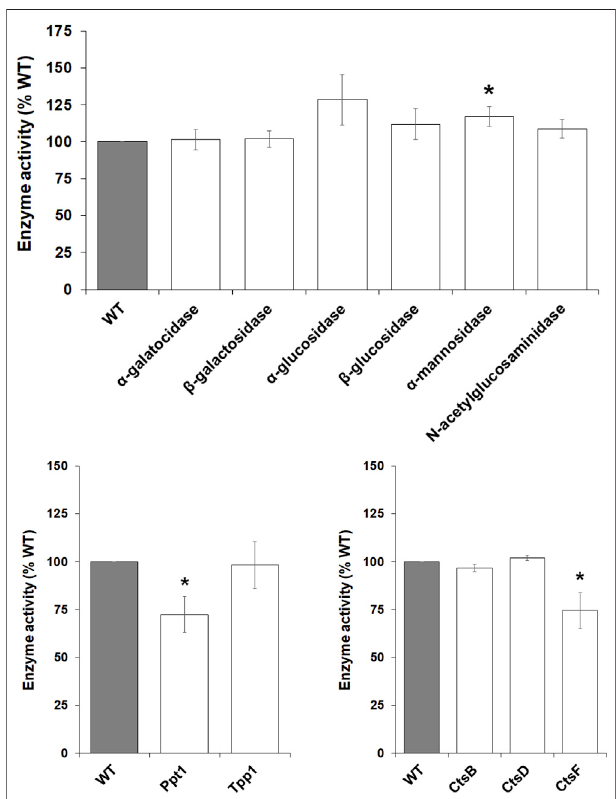
FIGURE 9 | Effect of mfsd8 -de fi ciency on enzyme activity during starvation. WT and mfsd8 − cells grown axenically in HL5 were starved in KK2 buffer for 4 h, after which time cells were lysed. The activities of α - galactosidase, β -galactosidase, α -glucosidase, β -glucosidase, α - mannosidase, N-acetylglucosaminidase, palmitoyl-protein thioesterase 1 (Ppt1), tripeptidyl peptidase 1 (Tpp1), cathepsin B (CtsB), cathepsin D (CtsD), and cathepsin F (CtsF) were assessed as described in the Materials and Methods. Data presented as mean enzyme activity (% WT) ± SEM ( n > 4). Statistical signi fi cance was determined using the one-sample t -test (mean, 100; two-tailed) vs. WT. * p < 0.05 and *** p < 0.001 vs. WT.